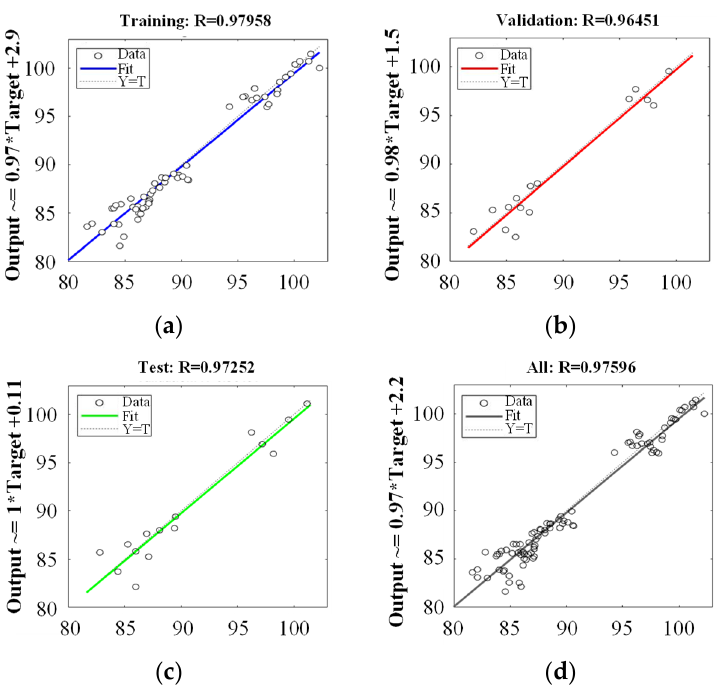
Figure 7. Regression plots; ( a ) Training; ( b ) Validation; ( c ) Test; ( d ) All data set.